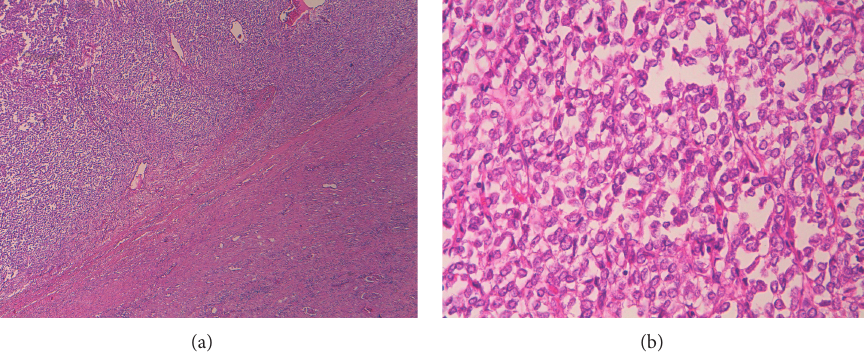
Figure 2: (a) Tumor tissue and intact parenchymal tissue ( × 40 hematoxylin-eosin). (b) The tumor cells with ovoid, round nuclei having coarse chromatin structure and a narrow eosinophilic cytoplasm ( × 400